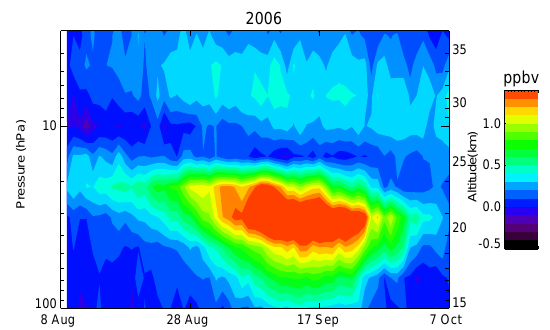
Figure 2. The zonally averaged daily ClO mixing ratio (day minus night) as measured by Aura MLS for